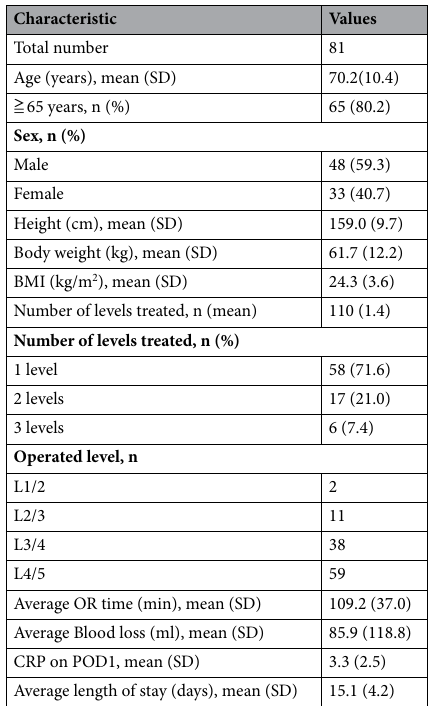
Table 1. Demographic information. SD standard